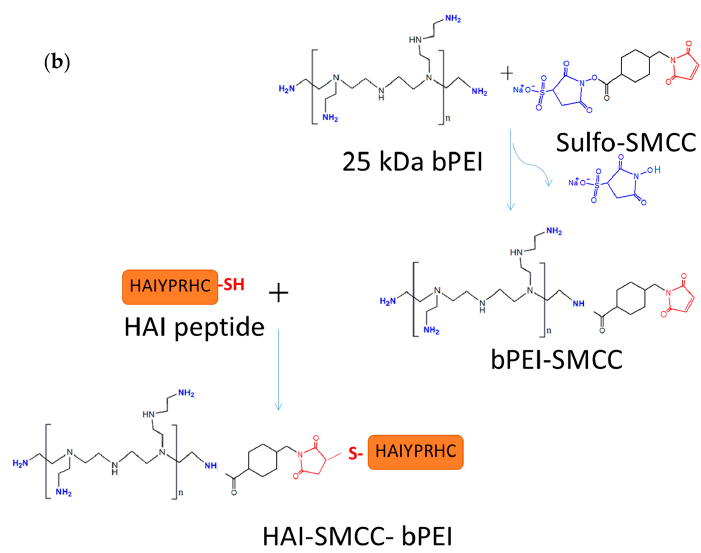
Figure 1. ( a ) Synthesis approach of HAI-SPDP-bPEI.; ( b ) Synthesis approach of HAI-SMCC-bPEI. (bPEI: branched polyethylenimine; PEG 4 -SPDP: 2-Pyridyldithiol-tetraoxatetradecane-N-hydroxysuccinimide; sulfo-SMCC: sulfosuccinimidyl 4-[N-maleimidomethyl]cyclohexane-1-carboxylate; DTT: dithiothreitol).